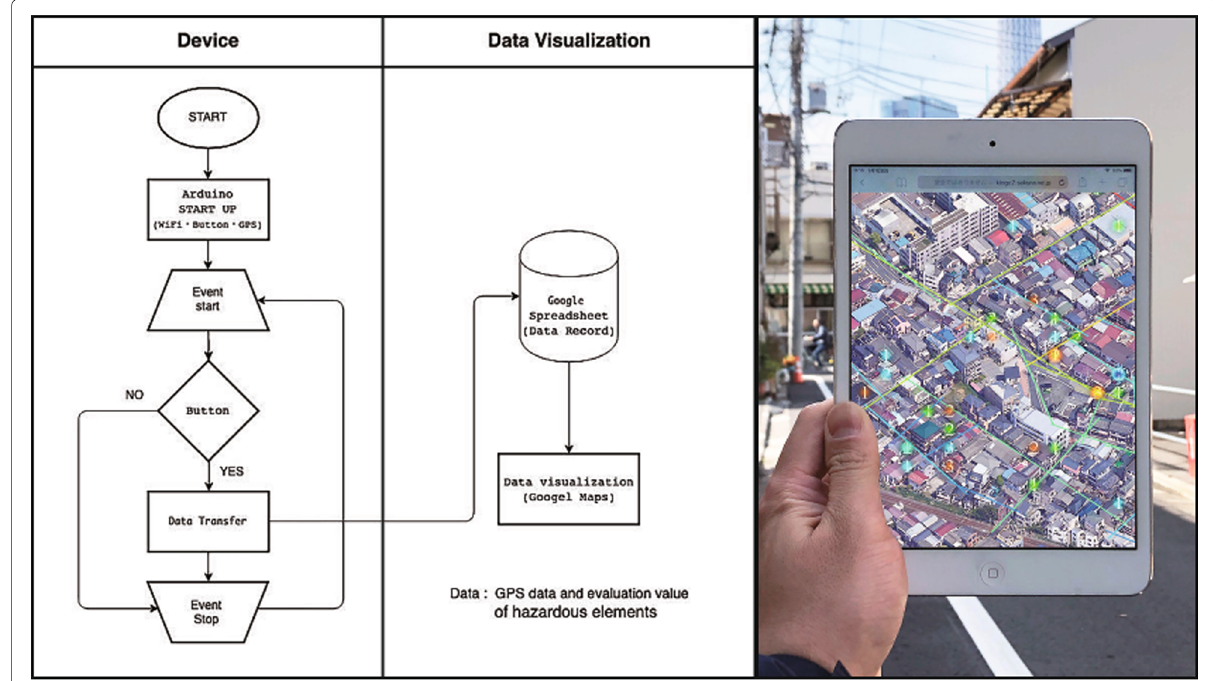
Fig. 4 Program flowchart of